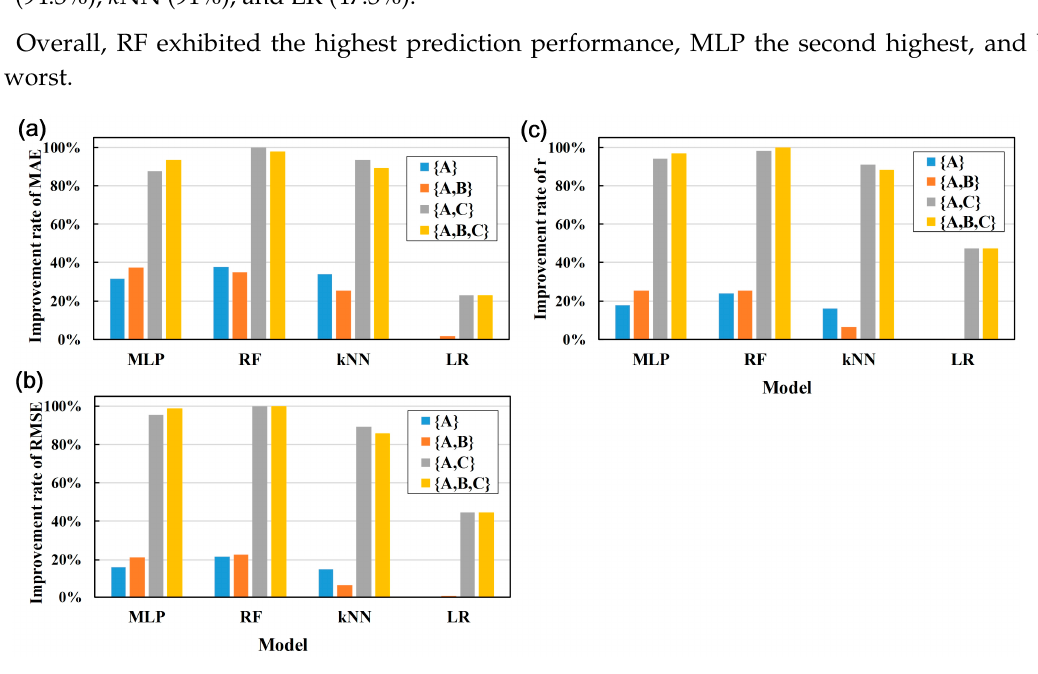
Figure 6. Improvement rates for MLP, RF, k NN, and LR with all dataset combinations: ( a ) MAE, ( b ) RMSE, and ( c ) r.